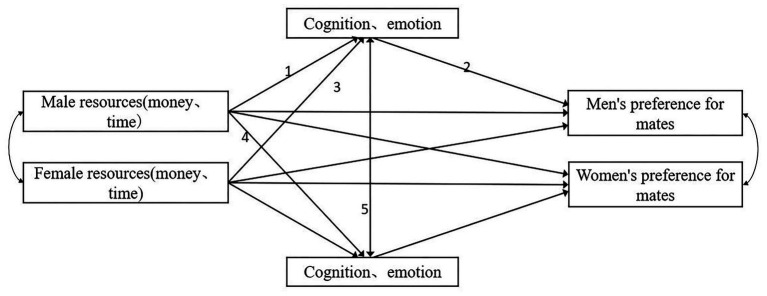
Male and female gender actor-partner effect model of the influence of monetary resources on mate choice preference.